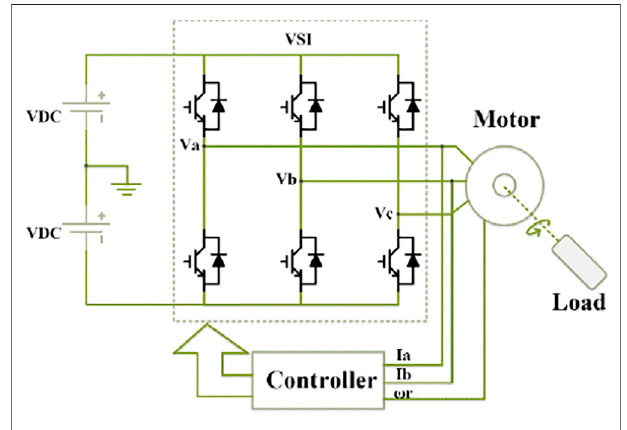
FIGURE 1 | Inverter-fed SPMSM system.